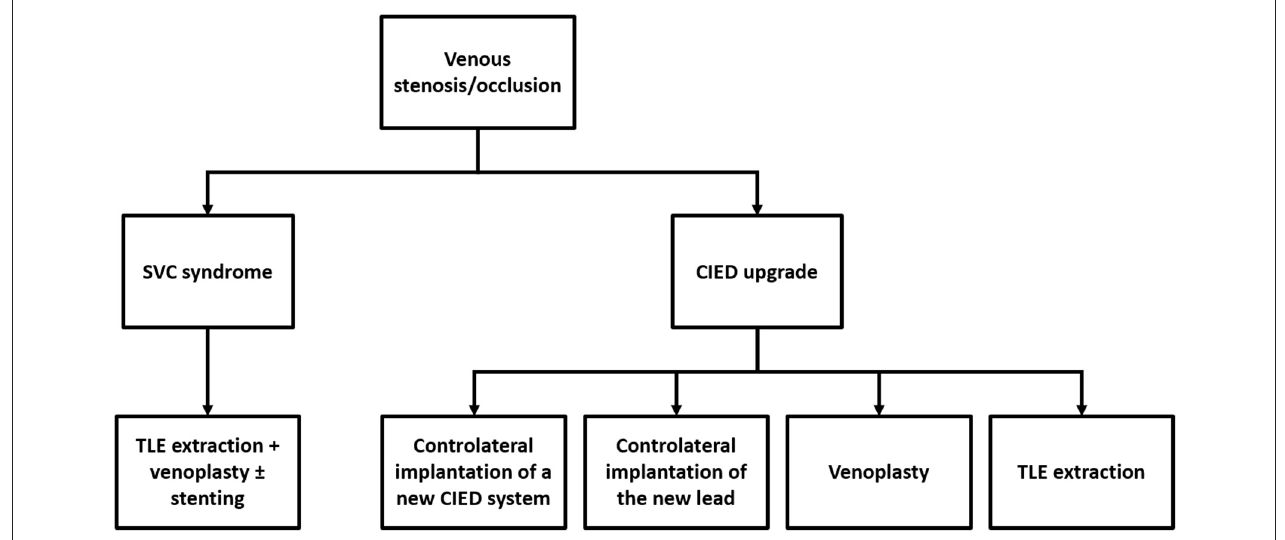
FIGURE 1 | Current therapeutic approach to treat or overcome venous stenosis/occlusion related to transvenous cardiac